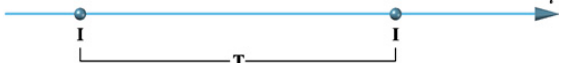
Figure 37. The two-time elements of the CM, represented as elements of a one-dimensional cell-complex.